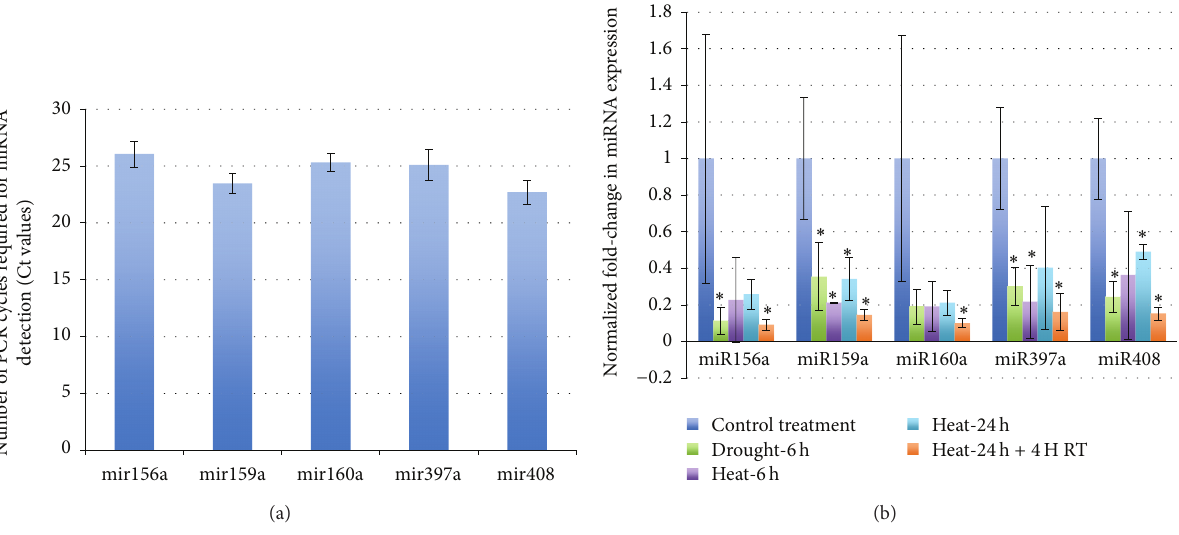
Figure 6: Validation of 5 predicted cassava miRNAs. (a) Mean cycle threshold (Ct) values showing the expression levels of the selected miRNAs under normal conditions; Ct values indicate the number of PCR cycles at which the amplification signal crosses a fixed threshold; lower Ct values correspond to higher expression levels. Error bars correspond to the standard deviation (SD) of Ct values ( 𝑛 = 3 ). (b) Comparison of the relative expression levels of the selected miRNAs under heat and drought treatments normalized to values in (a) using the 2 −ΔΔ Ct method. 18s rRNA was chosen as an endogenous control; error bars correspond to the normalized SD of 2 −ΔΔ Ct values ( 𝑛 = 3 ). ∗ : Mann-Whitney 𝑃 value <0.1 ; RT: Room